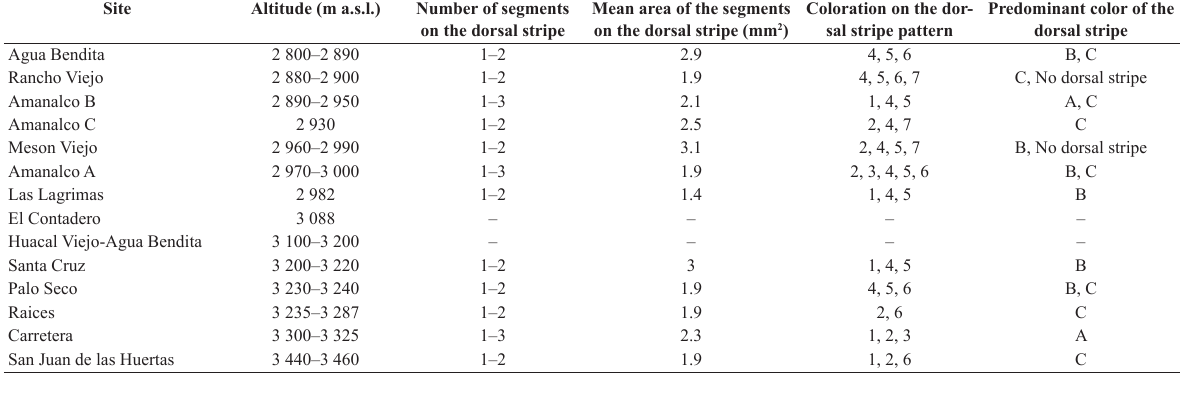
Table 2. Dorsal pattern and color of P. robertsi in each sampling site (sorted by elevation). Coloration pattern letters (A–C, 1–7) refer to Fig. 6. Site Altitude (m a.s.l.) Number of segments